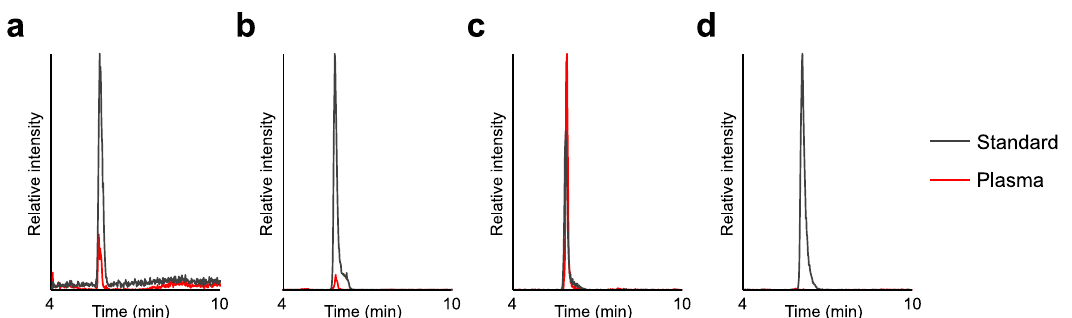
Fig. 2 MRM chromatograms of 3Hyp-containing di- and tripeptides in human plasma after oral ingestion of collagen hydrolysate. a Gly- 3Hyp, b 3Hyp-4Hyp, c Gly-3Hyp-4Hyp, and d 3Hyp-4Hyp-Gly were detected by LC – MS in MRM mode for respective standards (100 pg each) or deproteinized human plasma collected 1 h after the ingestion of porcine skin collagen